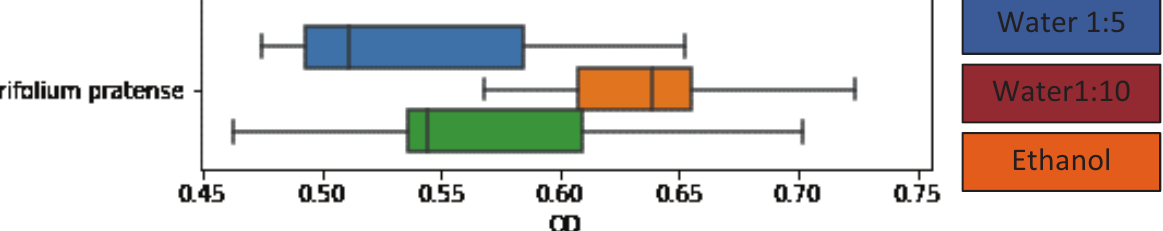
Figure 6. Schematic boxplots for the influence of extractant and its quantity on antioxidant action of T. pratense phytocompositions. Units are on the Pauling